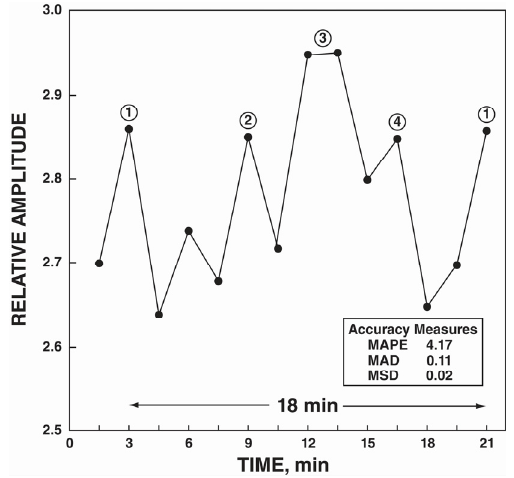
Figure 6. Decomposition fit [11] of luminesce data of Gudkov et al. [23] collected at intervals of 1 sec averaged over 1 min every 1.5 min prior to infrared laser activation. Maxima labeled ① and ② are separated by 6 min as for Figure